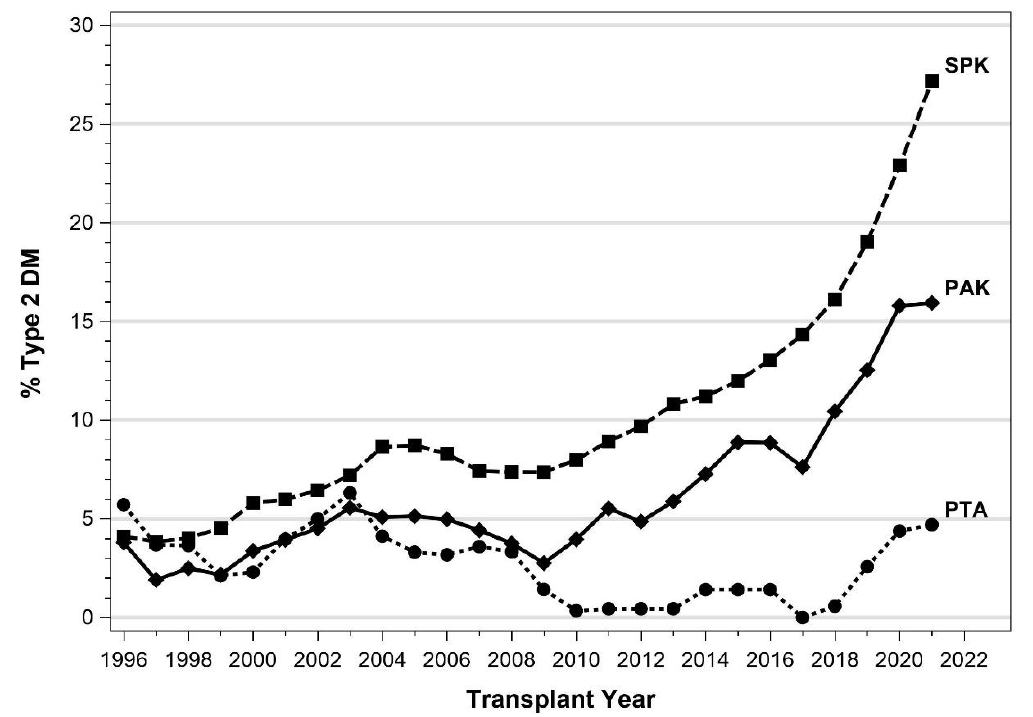
Figure 1. Proportion of recipients identified as having T2DM by year according to PTx category for US cases as reported to the IPTR.